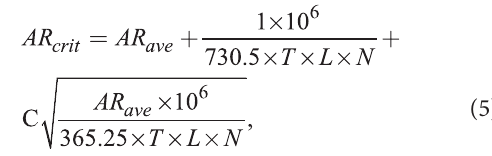
Table 1 . AR ave and AR av e on Latvian main roads in 2005–2007 Road No.